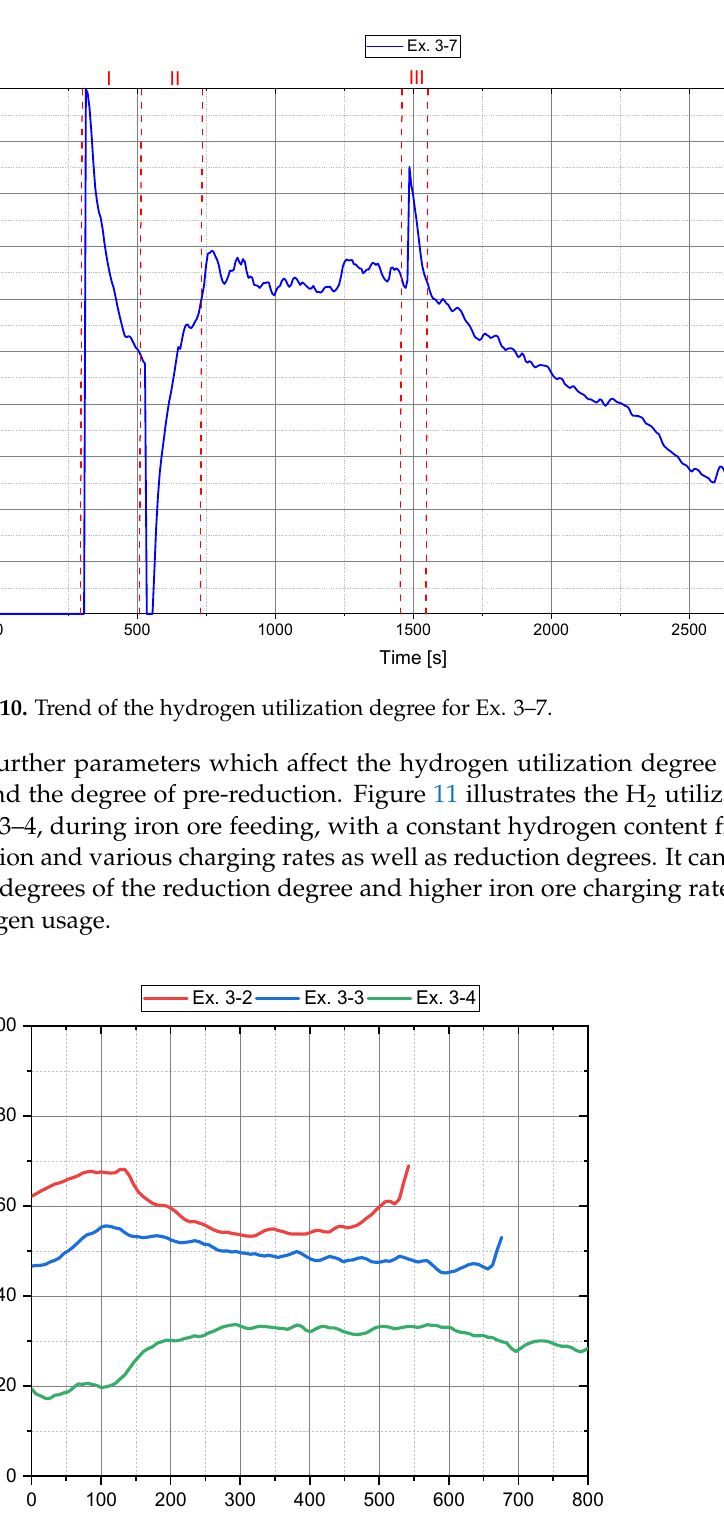
Figure 12. Hydrogen utilization during charging (Phase 4) for Ex. 3–1 and Ex. 3–5 to Ex. 3–7. 4.3. Statistical Analysis The preliminary and main experiments were also evaluated with the program MODDE ® 13 Pro from Sartorius AG to analyze the significant main effects on the